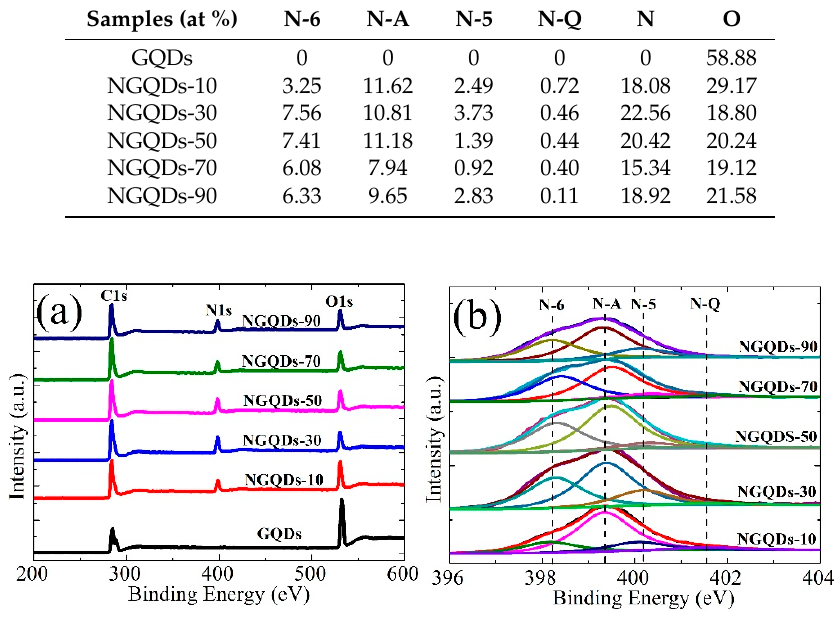
Figure 3. X-ray photoemission spectroscopy (XPS) spectra of the GQD and NGQD samples. ( a ) Wide scan urvey; ( b ) Fine-scanned N 1 s XPS spectra of the NGQD samples obtained at different irradiation times.